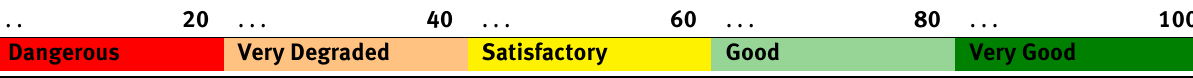
Table 5: Classification grid of the various elements P k (adapted from Shohet [13]).